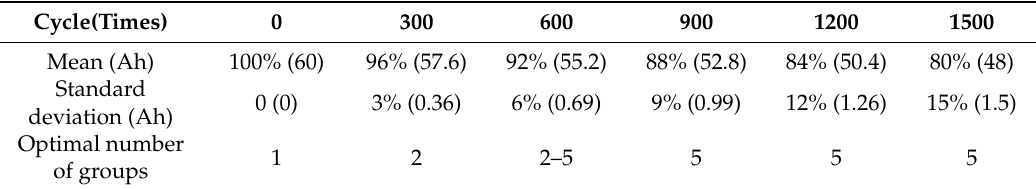
Table 4. Optimal number of groups in different stages.